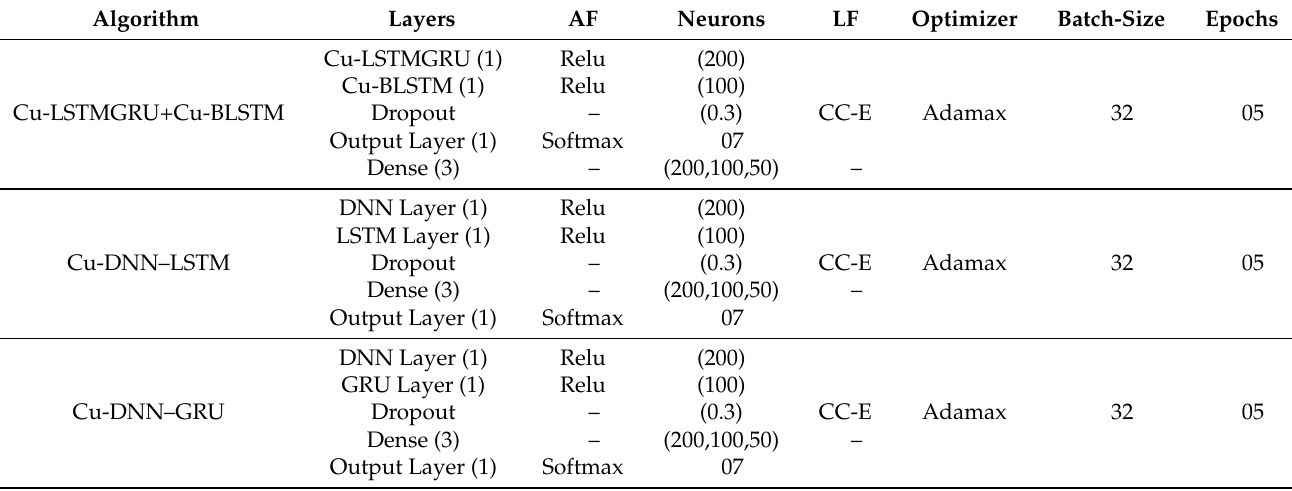
Table 2. Hybrid algorithms description.